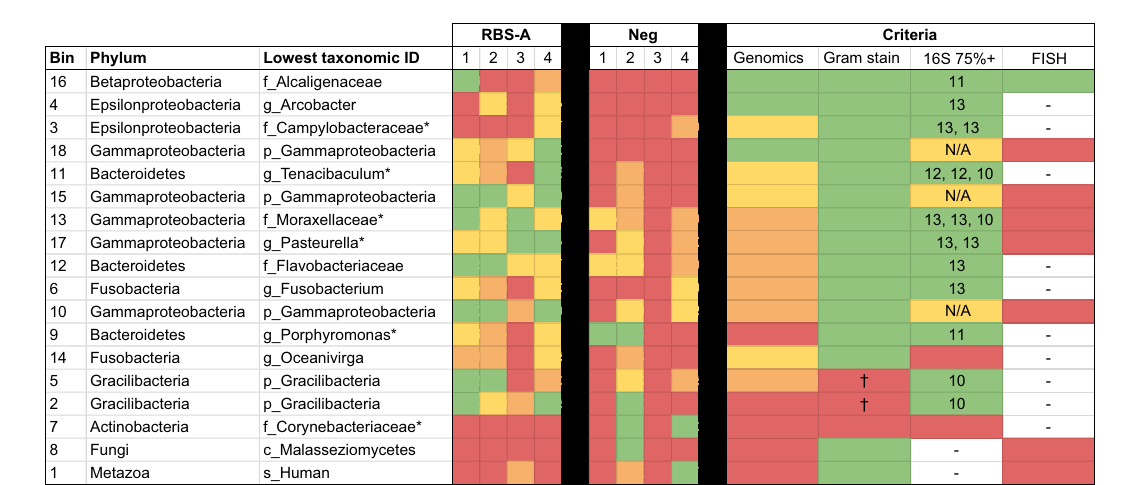
Fig. 4 | Insights into RBS-A identity. The table shows the 18 bins recovered from MDAandsequencingofRBS-Asamplescollectedviamicromanipulator,alongwith the phylum from which they are inferred to derive. For the lowest taxonomic identity achieved (or class, in the case of the polyphyletic phylum Proteobacteria), an asterisk (*) denotes lower con fi dence in the assignment (Methods). The RBS-A paneldepictsrelativeabundancesofbinsineachofthefoursamplesthatcontained RBS-As based on visualization, color-coded as follows: green: ≥ 5%, yellow: ≥ 1% and <5%, orange: >0% and <1%, red: 0%. The negative-control panel (Neg) presents the same information for each of the samples that did not appear to contain RBS-As. Criteria for gauging the likelihood of a bin deriving from the RBS-As are shown: (Genomics) Wasthe binever presentin negative controls(green= no, yellow = yes butnever ≥ 1%relativeabundance,orange=yesbutnever ≥ 5%,red=yesandatleast